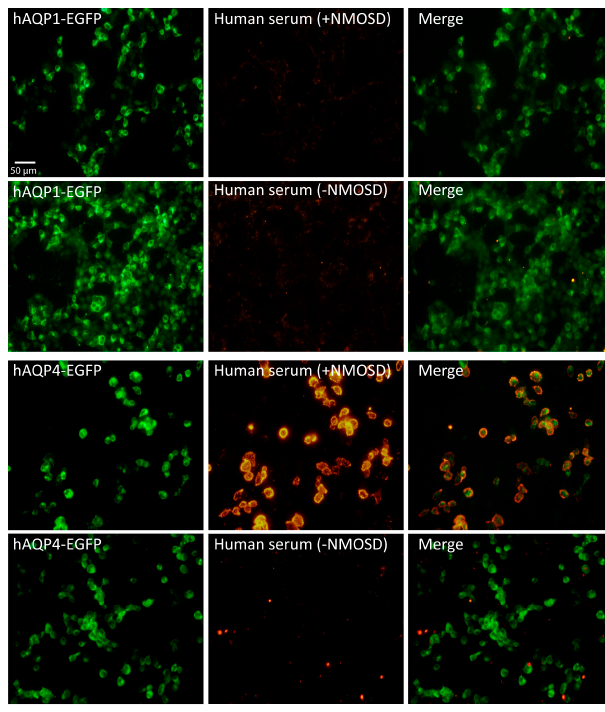
Figure 1. Immunofluorescence assay in HEK cells expressing AQP1 or AQP4 with serum of patients. The fluorescence signal from HEK cells expressing human AQP1 (hAQP1-EGFP) or AQP4 (hAQP4-EGFP) fused to GFP is shown in green (left column). In the central panels the immune reaction produced by serum patients either from the Neuromyelitis optica spectrum disorder (+NMOSD) or not ( − NMOSD) over AQP1 expressing cells revealed absence of anti-AQP1 antibodies in analyzed serums. In contrast, serum from a positive anti-AQP4 antibody patient (+NMOSD) showed clear reactivity over AQP4 expressing cells (yellow signal), while negative results are obtained in the absence of IgG anti-AQP4 in a patient ( − NMOSD). The merge image of both fluorescent signals is shown in the right column. Scale bar = 50 µm.